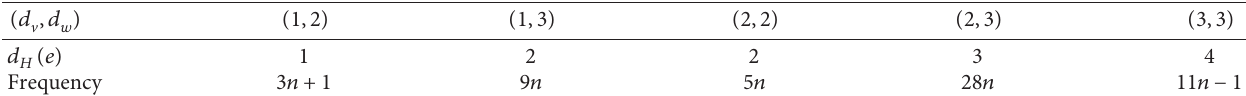
Table 2: Edge partition of H